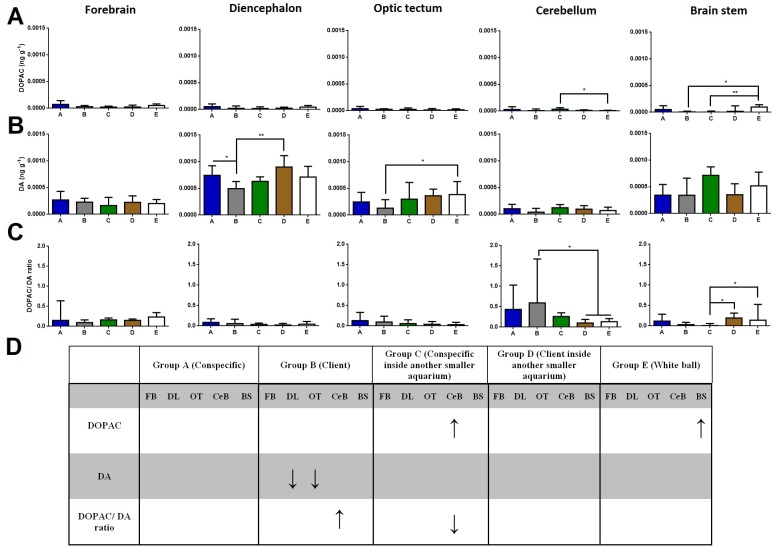
DOPAC, DA, and DOPAC/DA ratio in different brain areas, and different treatments.(A) DOPAC levels, in the forebrain (K = 8.901; p = 0.0636), diencephalon (K = 7.620; p = 0.1065), optic tectum (K = 2.115; p = 0.7146), cerebellum (K = 13.51; p = 0.0090), brain stem (K = 16.7; p = 0.0022); (B) DA levels, in the forebrain (K = 4.223; p = 0.3767), diencephalon (K = 16.18; p = 0.0028), optic tectum (K = 11.21; p = 0.0243), cerebellum (K = 8.428; p = 0.0771), brain stem (K = 6.268; p = 0.18); (C) DOPAC/DA ratio, in the forebrain (K = 5.328; p = 0.2553), diencephalon (K = 5.67; p = 0.2252), optic tectum (K = 4.483; p = 0.3446), cerebellum (K = 15.17; p = 0.0044), brain stem (K = 15.85; p = 0.0032); (D) significant changes in different social contexts. Medians and interquartile ranges are shown. Significant values are shown above bars: * <0.05; ** <0.01; and refer to Dunn’s Post-Hoc tests.